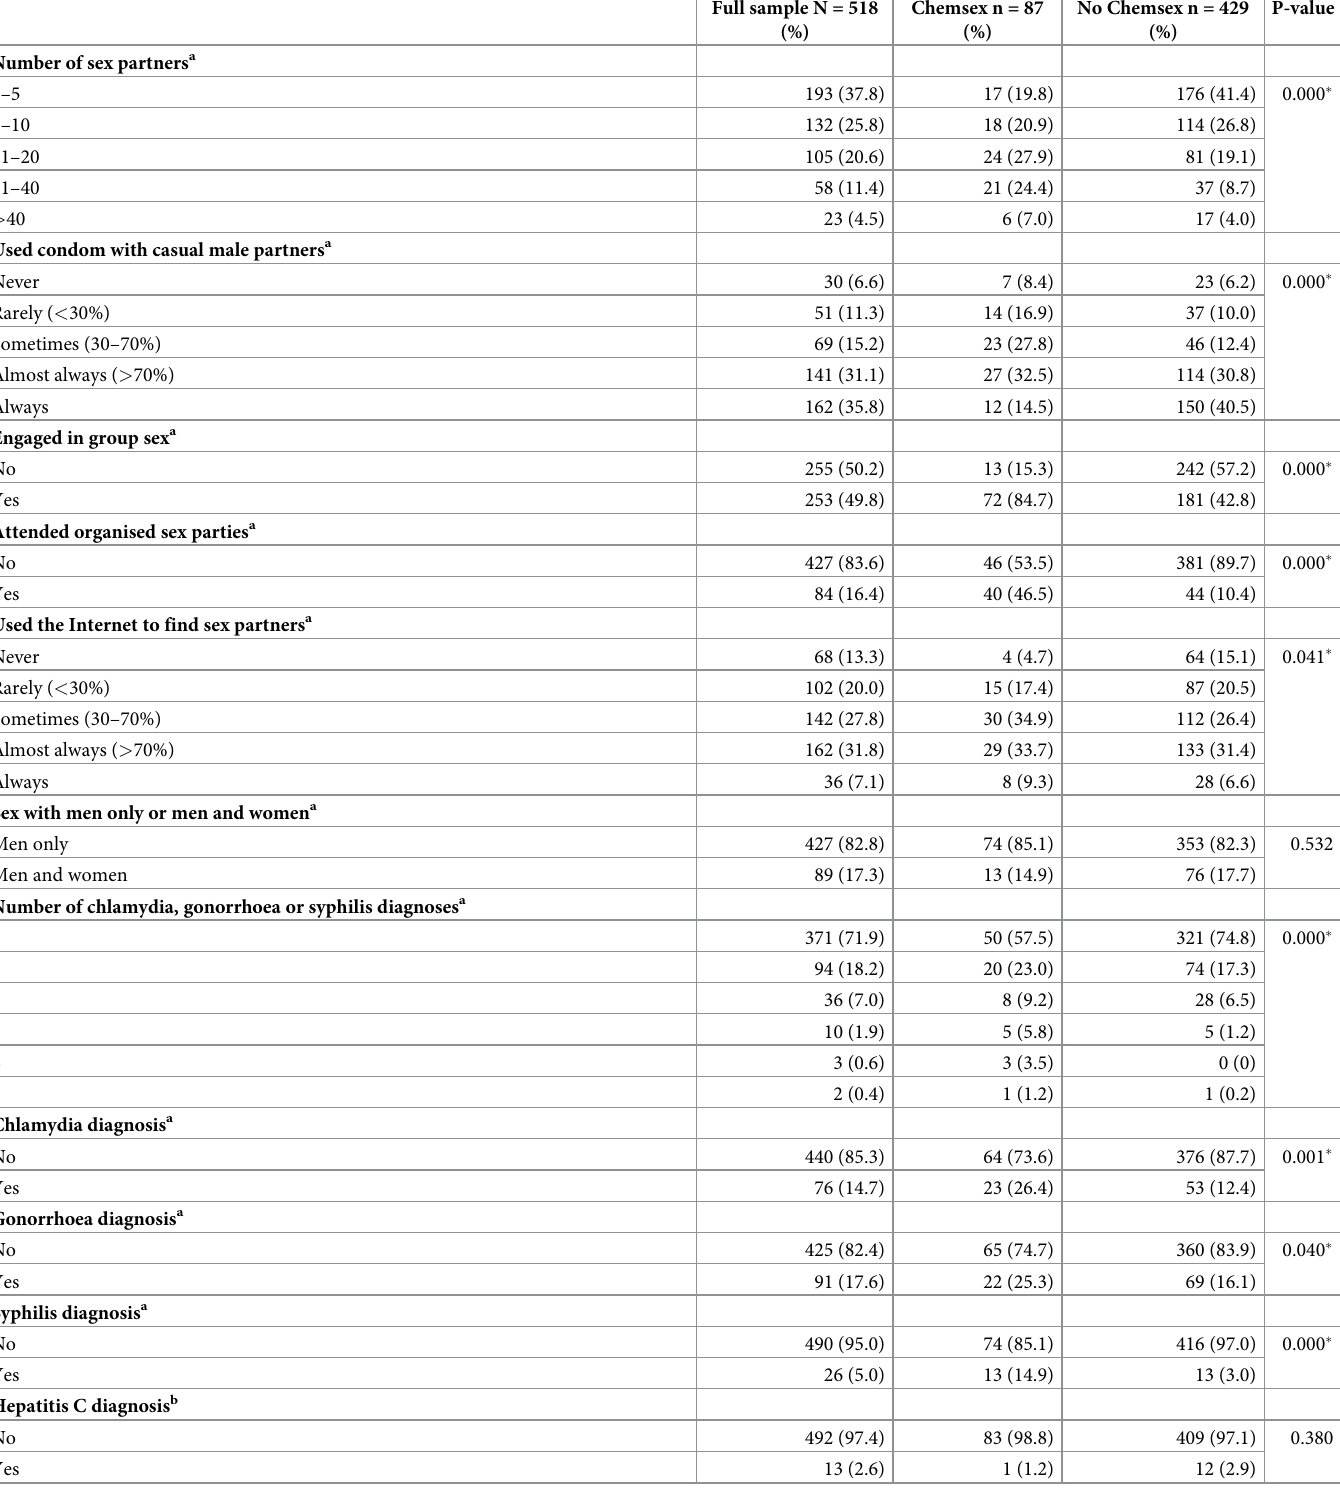
Table 2. Self-reported sexual behaviour and health among the sample and